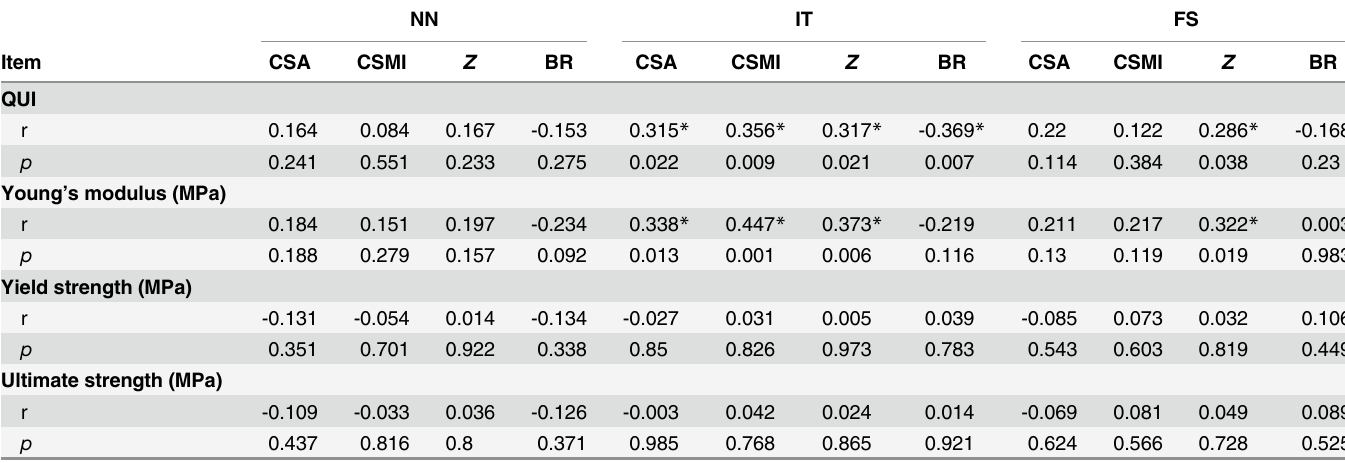
The NN.CSA, NN.CSMI, NN. Z and NN.BR indicate the CSA, CSMI, Z and BR of the femoral neck area, respectively. The NN, IT, and FS indicate the femoral neck, trochanteric area, and femoral shaft, respectively. CSA: cross-sectional area; CSMI: cross-sectional moment of inertia; Z : section modulus; BR, Buckling ratio. * p <